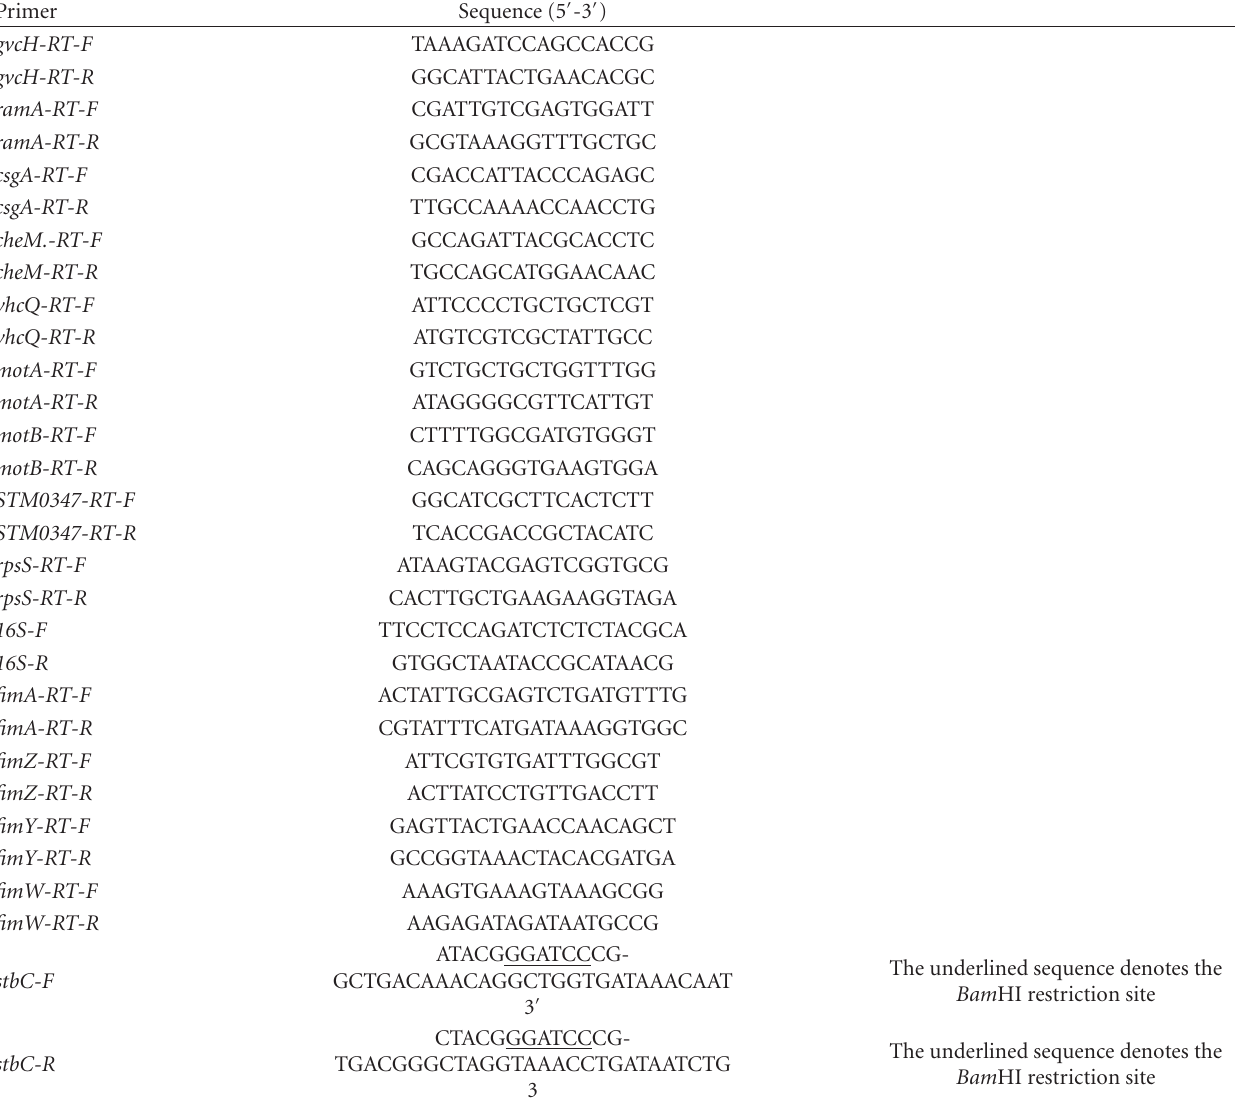
Table 1: Oligonucleotide primers used in the present study.